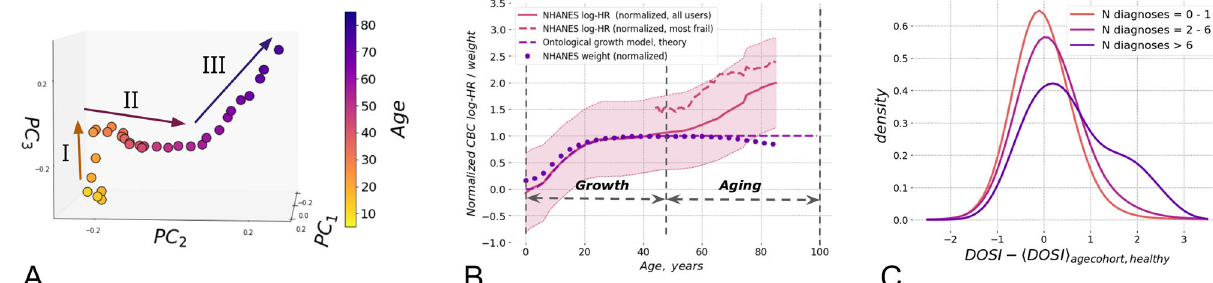
Fig. 1 Quanti fi cation of aging and development. A The graphical representation of the PCA for 5 – 85 year old NHANES participants follows an age-cohort averaged aging trajectory. Centers of each sequential age cohort are plotted in fi rst three PCs. Three approximately linear segments are clearly seen in aging trajectory, corresponding to (I) age < 35; (II) age 35 – 65; (III) age > 65. B Dynamic organism state indicator (DOSI) mean values (solid line) and variance (shaded area) are plotted relative to age for all participants of NHANES study. The average line demonstrates nearly linear growth after age of 40. In younger ages the dependence of age is different and consistent with the universal curve suggested by the general model for ontogenetic growth 31 . To illustrate the general character of this early-life dependence we superimposed it with the curve of mean weight in age cohorts of the same population (dotted line). All values are plotted in normalized from as in 31 . The average DOSI of the “ most frail ” ( “ compound morbidity index ” , CMI > 0.6) individuals is shown with the dashed line. C Distributions of sex- and age-adjusted DOSI in cohorts of NHANES participants in different morbidity categories relative to the DOSI mean in cohorts of “ non-frail ” (1 or no diagnoses, CMI < 0.1) individuals. Note that the distribution function in the “ most frail ” group (more than six diagnoses, CMI > 0.6) exhibited the largest shift and a profound deviation from the symmetric